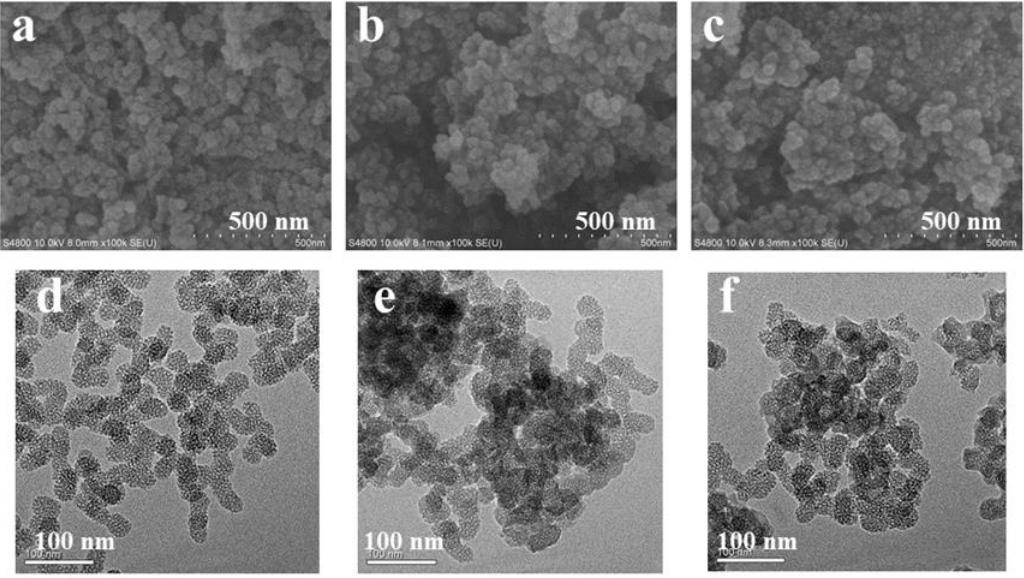
Figure 2. SEM images of ( a ) MSN, ( b ) MSN-PEI, and ( c ) MSN-PEI-FA; the TEM images of ( d ) MSN, ( e ) MSN-PEI, and ( f ) MSN-PEI-FA.